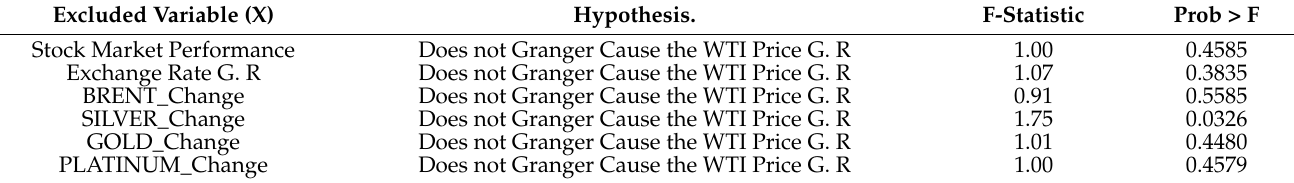
Table A15. Granger Causality test related to the WTI Price G. R (Regression with Driscoll–Kraay Approach). Excluded Variable (X)